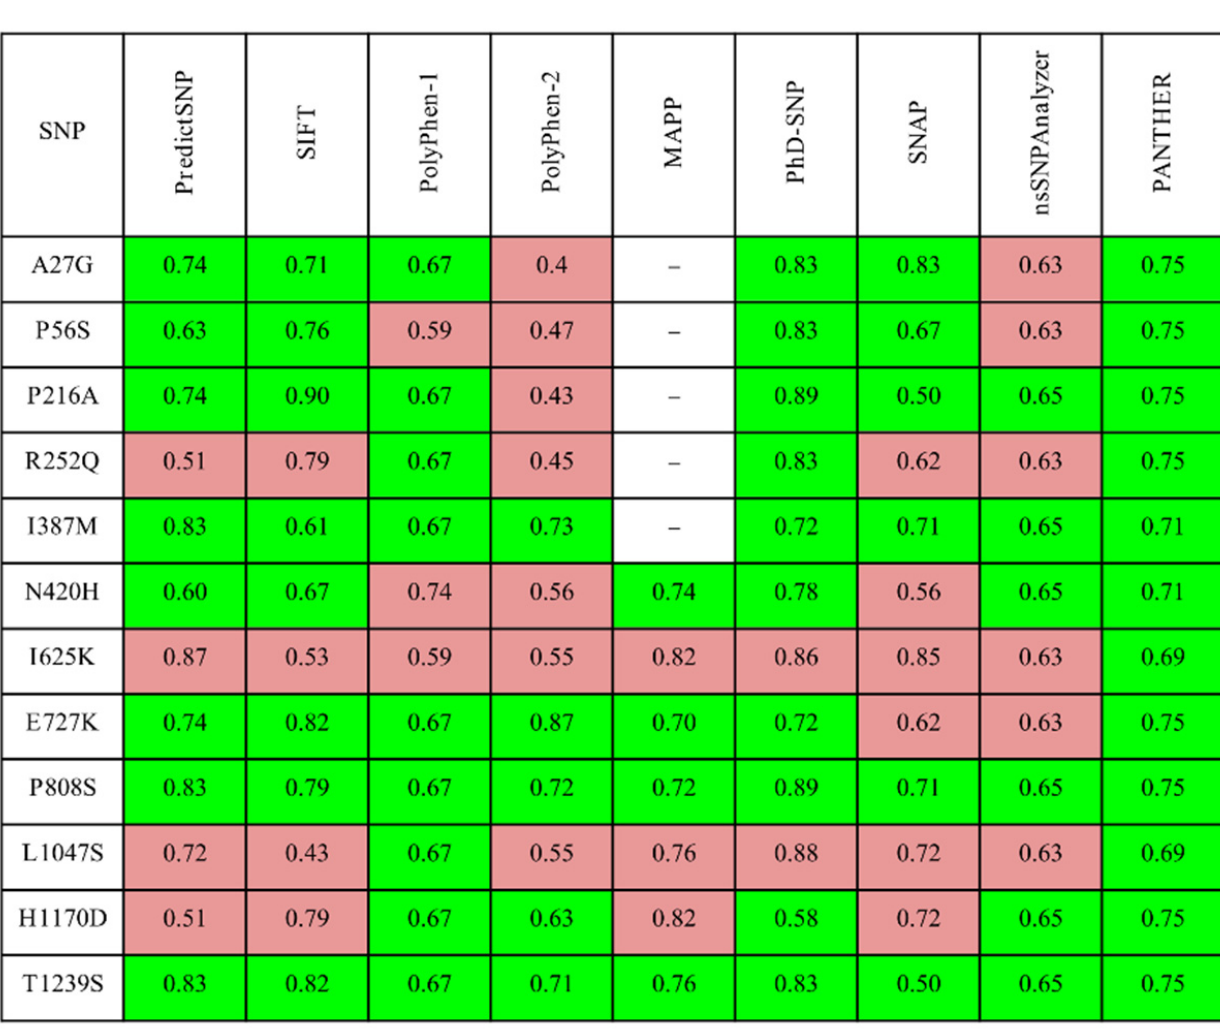
Figure 1. The expected accuracy results of the SNPs of DROSHA predicted as deleterious (marked in red) or benign (highlighted in green) in the PredictSNP server and integrated tools.